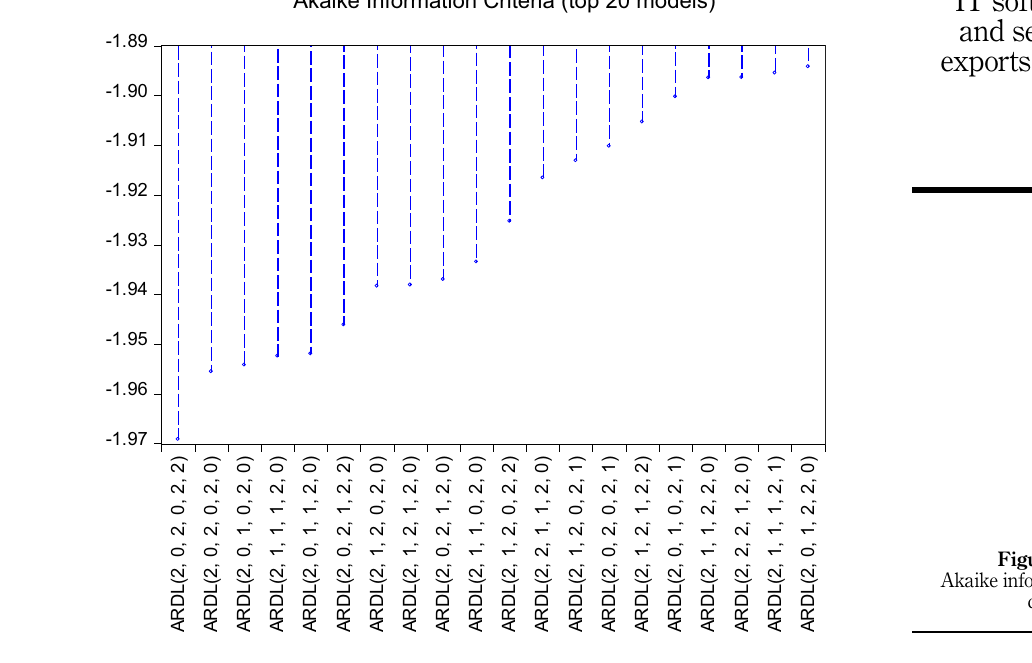
Figure A5. Akaike information criteria ’